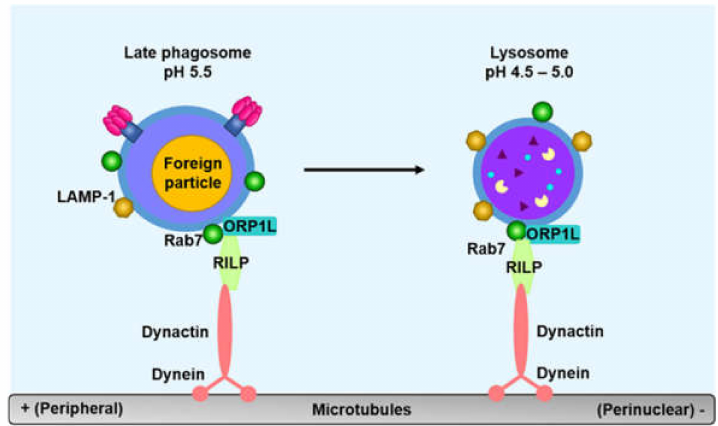
Figure 6. Model of the formation of phagolysosomes. For the fusion of late phagosomes and lysosomes, GTP-bound Rab7 interacts with new proteins, such as RILP and ORP1L. RILP recruits the dynein-dynactin motor complex, which moves Rab7-expressing late phagosomes toward the ( − ) end of the microtubule. The late phagosome then interacts and fuses with the